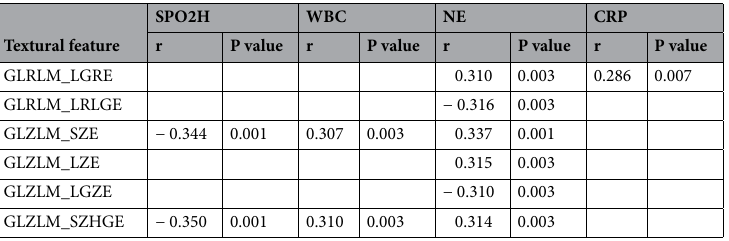
Table 2. Correlation analysis results between the textural features and the laboratory test index of